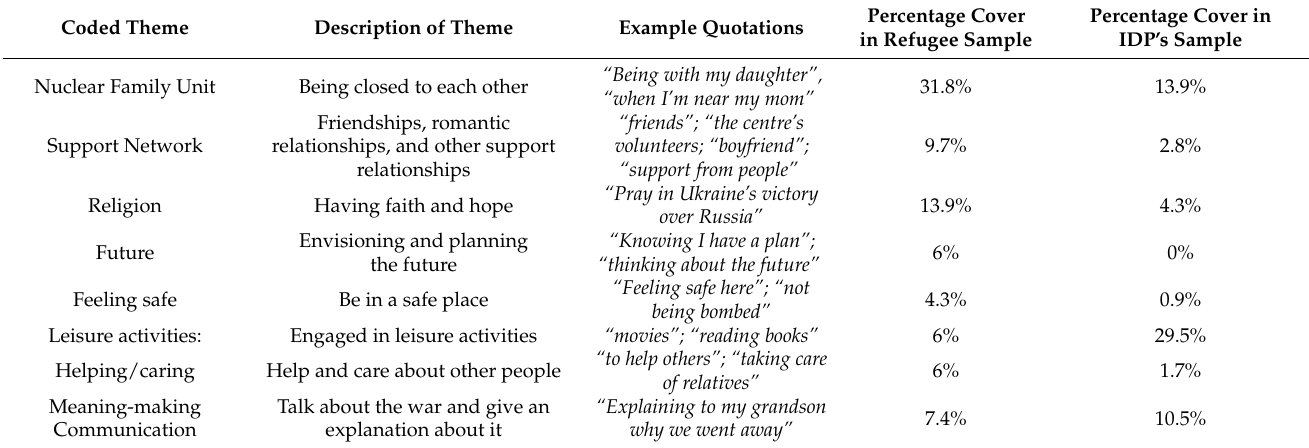
Table 2. Themes for the question “What makes you feel better?”.